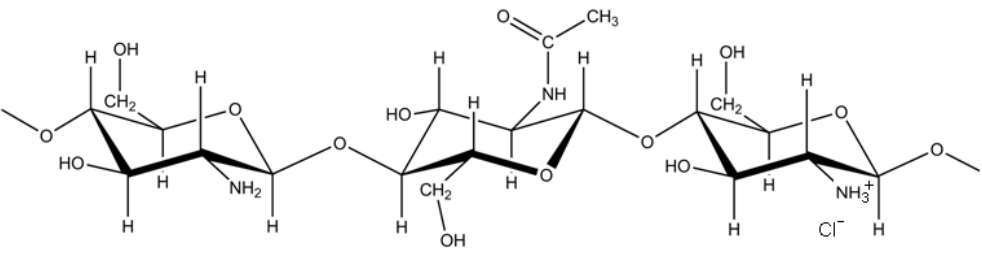
Figure 1. Chemical structure of chitosan, a polysaccharide with heterogeneous GlcNA content.